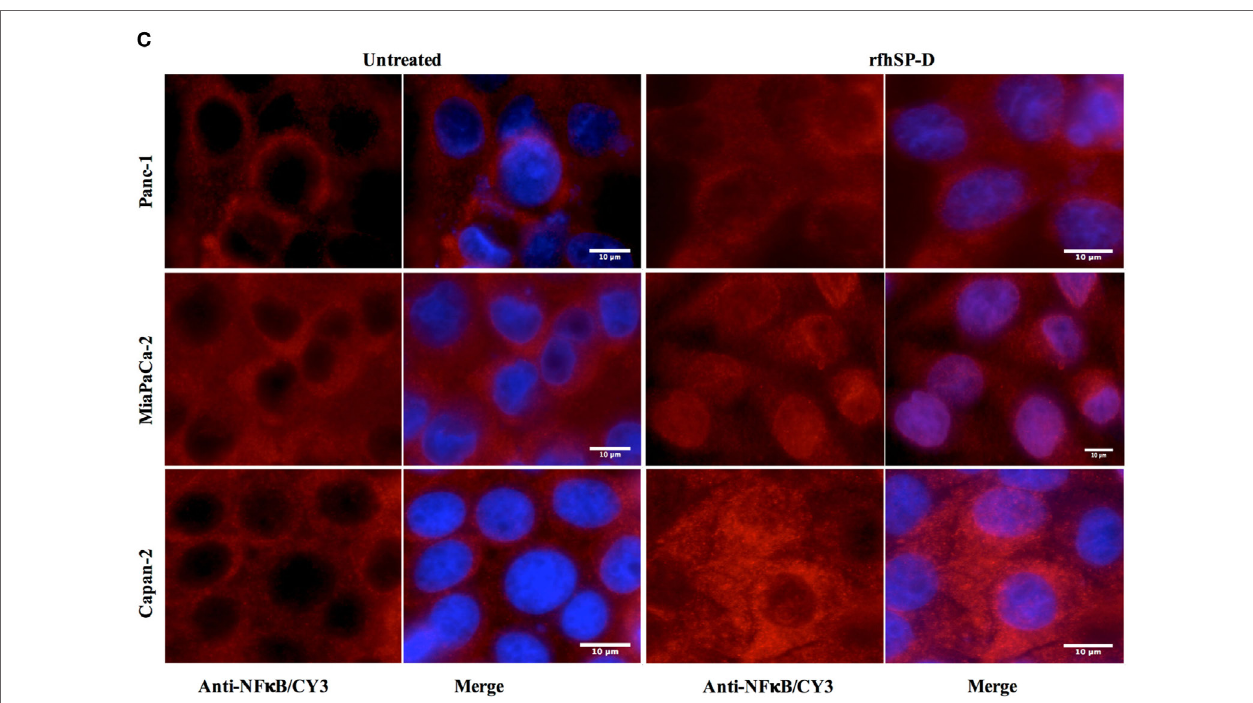
FigUre 7 | Relative quantification (RQ) comparisons of TNF- α (a) and NF- κ B (b) mRNA expression in Panc-1, MiaPaCa-2, and Capan-2 cell lines treated with rfhSP-D (20 µg/ml) for 12 and 24 h. The transcriptional expressions of both TNF- α and NF- κ B were upregulated in the treated samples at 12 and 24 h as compared to untreated. Significance was determined using the unpaired two-way ANOVA test (* p < 0.05, *** p < 0.001, **** p < 0.0001) ( n = 3). (c) Immunofluorescence microscopy to determine the translocation of NF- κ B into nucleus following rfhSP-D treatment. Anti-NF- κ B stained positively in the nucleus of treated cells as compared to untreated in all cell lines at 24